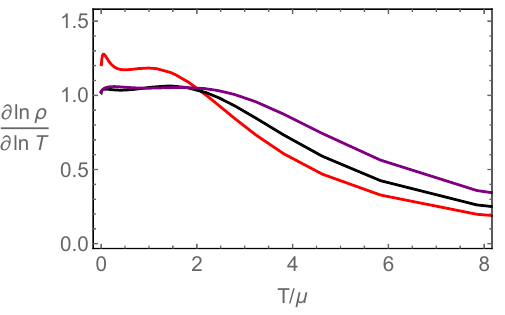
Figure 8. The exponent x in (cid:26) (cid:24) T x . The black curve corresponds to the black dot in (cid:12)gure 7a. The purple (red) curve corresponds to the square in (cid:12)gure 7a ((cid:12)gure 7c).